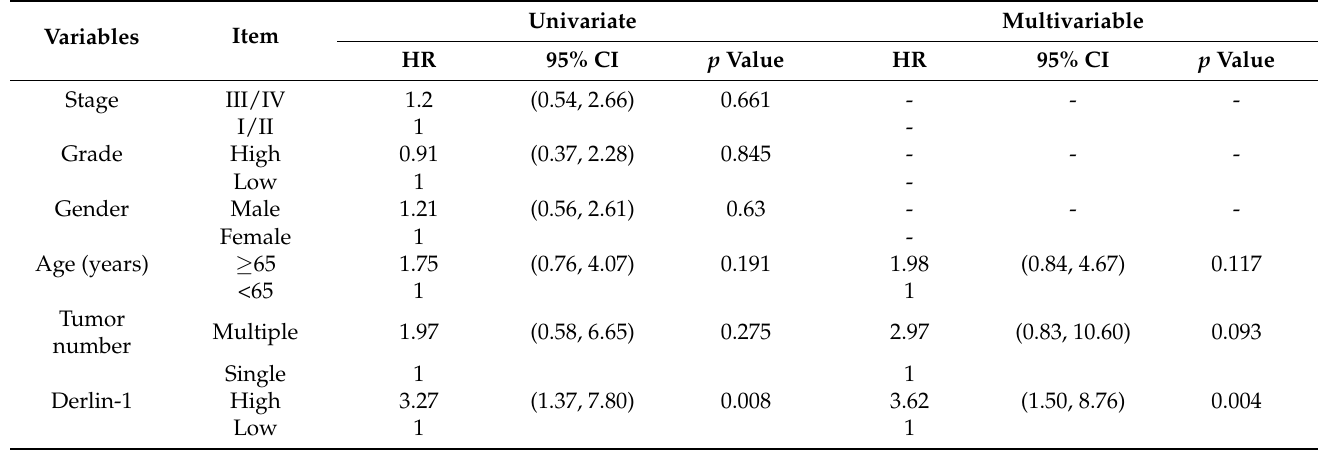
Table 2. Analysis of bladder recurrence-free survival for UTUC.